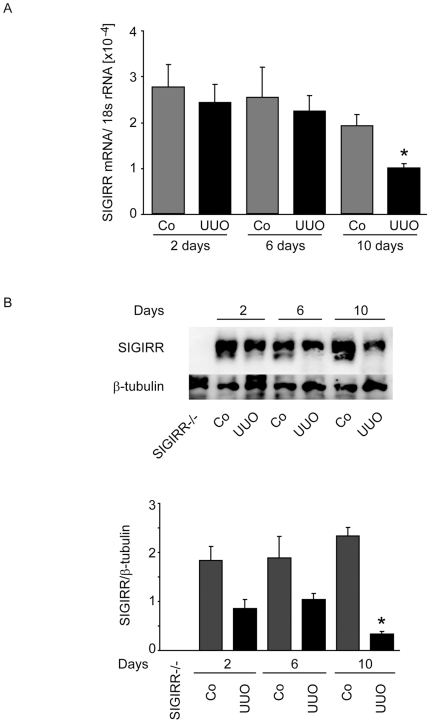
Renal SIGIRR expression after UUO.A. Wildtype mice underwent surgery and UUO kidneys (black bars) or contralateral kidneys (Co, grey bars) were harvested at different time points after surgery as indicated. mRNA expression levels were determined by real-time RT-PCR and related to the respective 18S rRNA expression. Data are expressed as means ± SD. * p<0.05 versus wildtype of the same time point, # p<0.05 versus time point day 2. B. Protein samples were obtained from the same kidney for SIGIRR Western blot. A kidney from Sigirr-deficient mouse served as negative control for the specificity of the SIGIRR antibody. β-tubulin staining is given as a loading control. The quantitative analysis is shown below. *p<0.05 versus contralateral kidney.